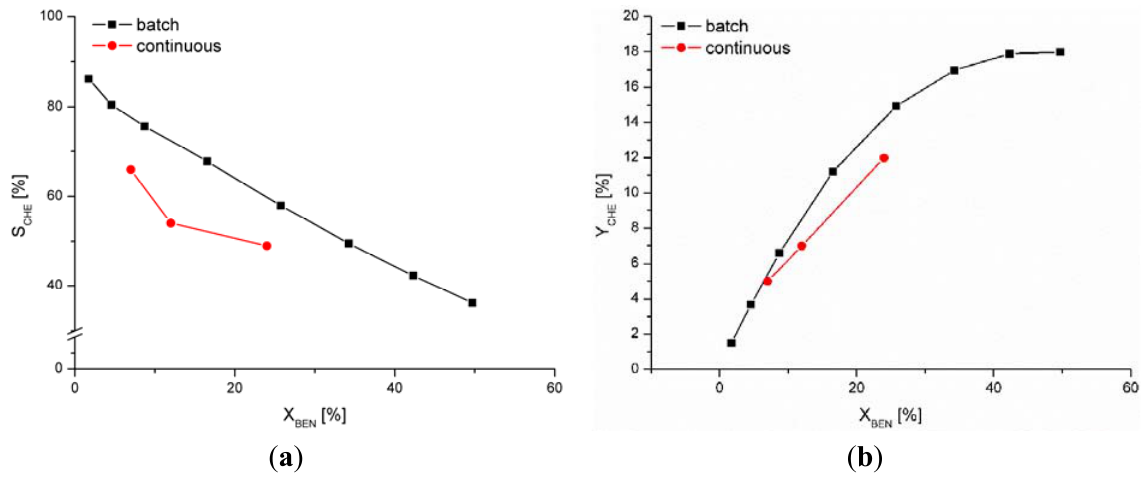
Figure 5. Cyclohexene selectivity against the conversion ( a ) and yield against the conversion ( b ) of benzene. (Reaction conditions: 1.5 g 2Ru/La 2 O 3 –ZnO, 4 mg NaDCA, 20 bar H 2 , V water / V benzene = 2/1, 1000 rpm, 150 °C).